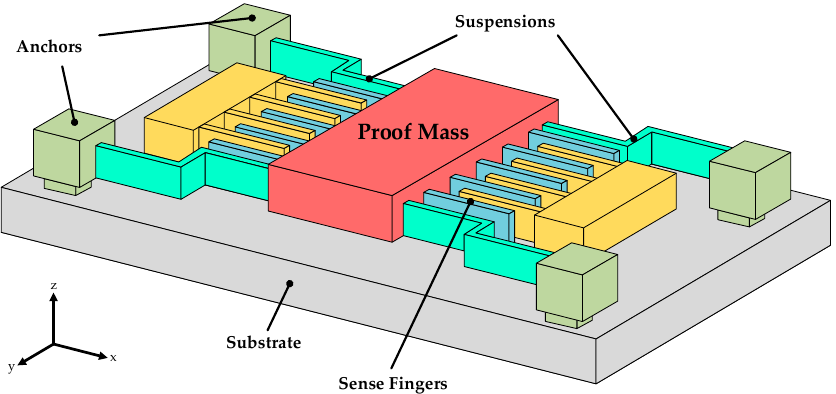
Figure 3. Schematic diagram of driving fingers.